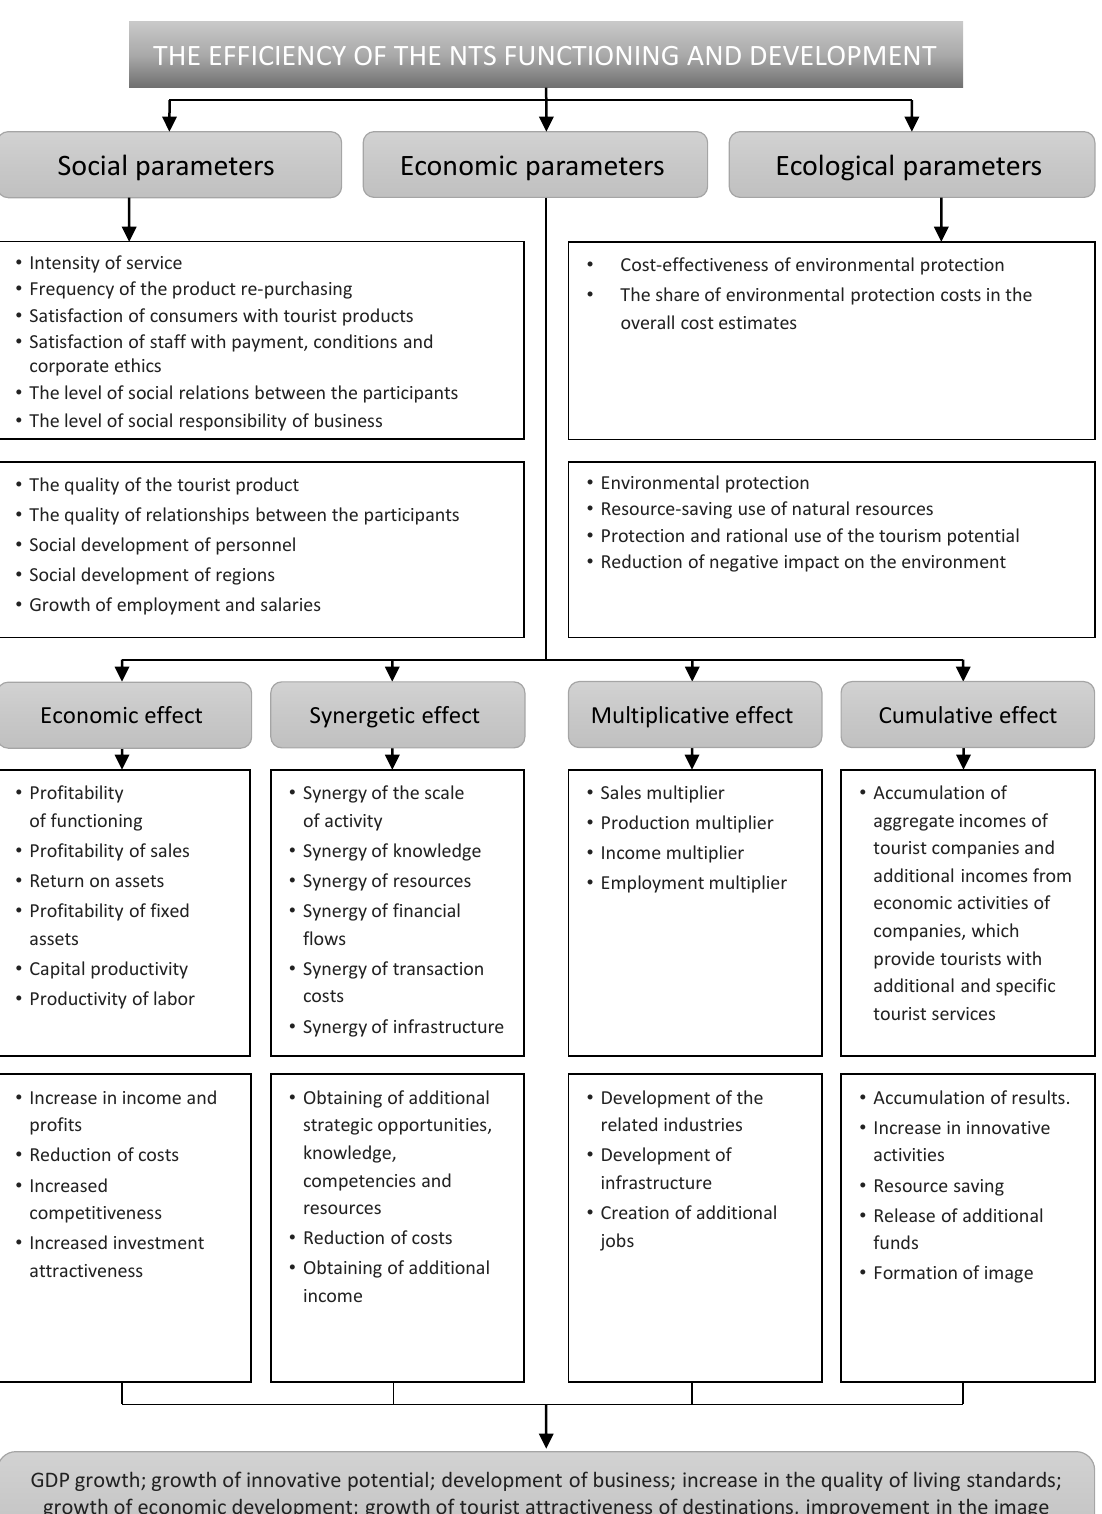
Figure 6. Configuration of the NTS functioning and